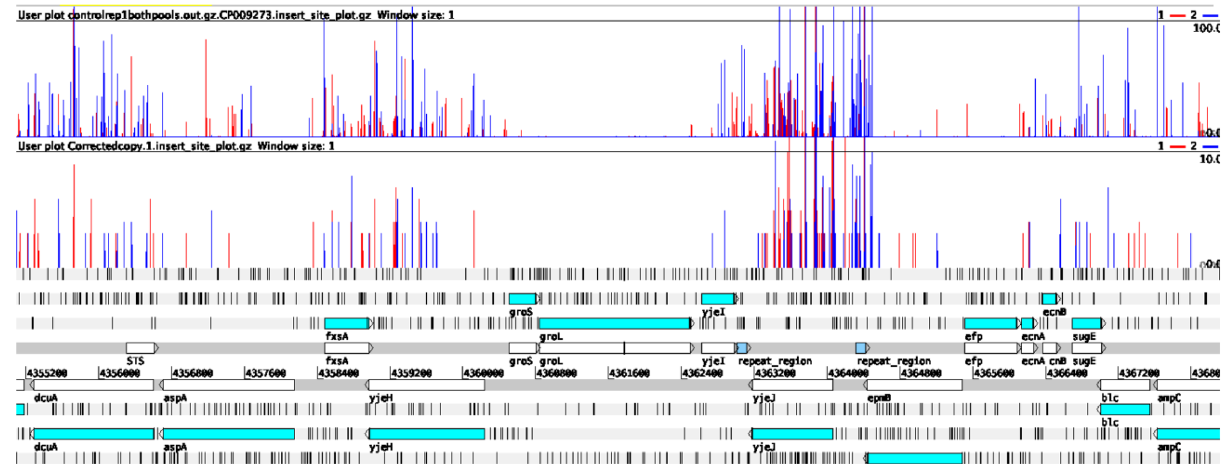
Figure 3. Comparison of transposon insertions sites identified using TraDIS- Xpress and LoRTIS. A genetic map of the relative gene positions is shown at the bottom of the panel. White arrowhead boxes represent the position of genes and blue arrowhead boxes represent encoded proteins from the genetic code. Above this, each row of vertical red or blue lines indicates the position of reads that mapped to the forward strand or reverse strand, respectively. The height of the bar represents the relative number of reads mapped to each position. The top row shows TraDIS- Xpress data, and the bottom row shows LoRTIS data, demonstrating the similarity between data generated by the two different methods.